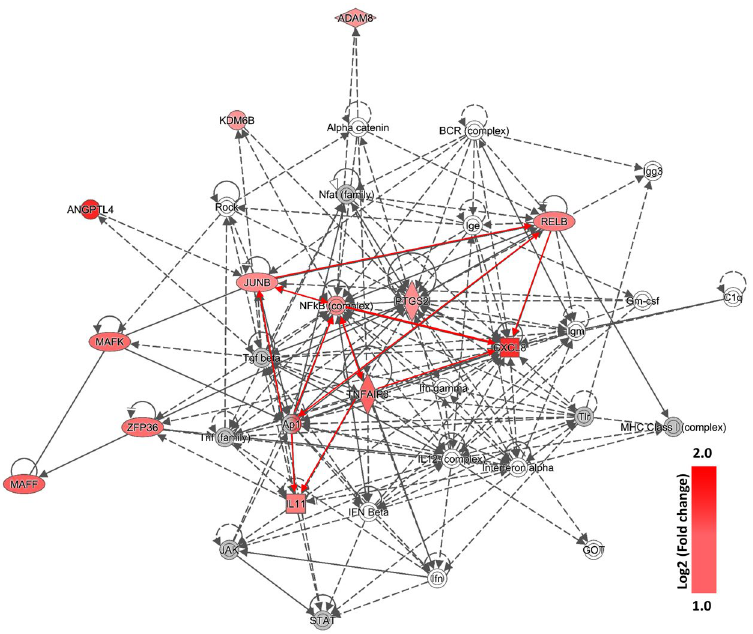
Figure 5. Sub-network of the innate signaling pathway obtained after IPA analysis of the differentially expressed genes in A549 lung epithelial cells infected with WM 06.482 conidia. Significantly up-regulated genes are shown in red, the intensity of red color shows the level of up-regulation of the gene expressed as log2 (fold change). The genes that did not show any changes in expression after 8 h of incubation with WM 06.482 are shown in grey. The full network is presented as Supplementary Fig.